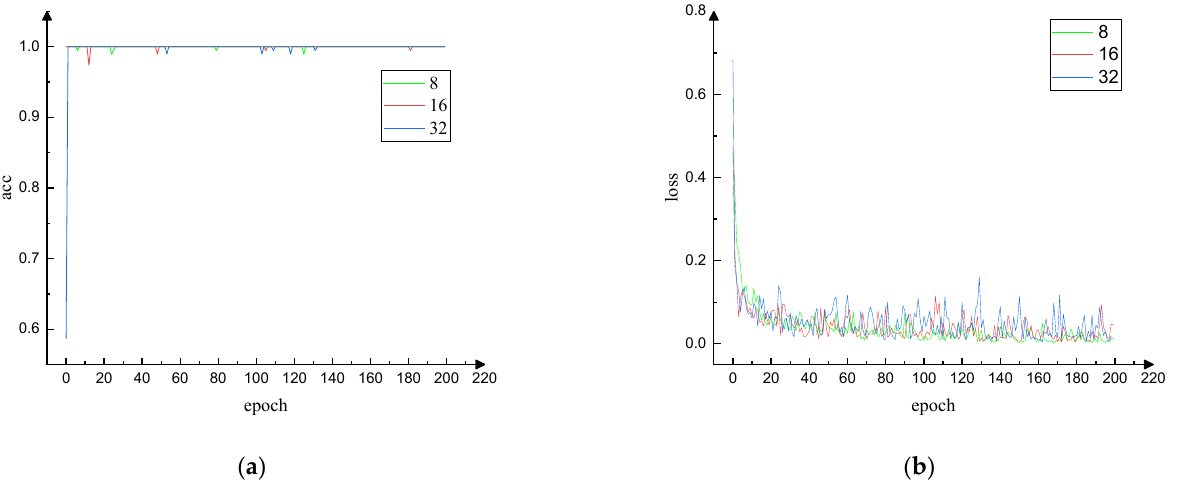
Figure 18. ( a ) Effect of different batch sizes on test accuracy. ( b ) Effect of different batch sizes on training loss.